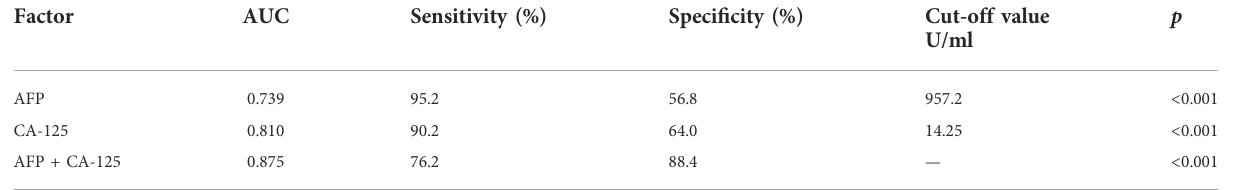
TABLE 4 The AUC, sensitivity, speci fi city and cut-off value for single risk factors in predicting OM from primary liver cancer. Factor AUC Sensitivity (%) Speci fi city